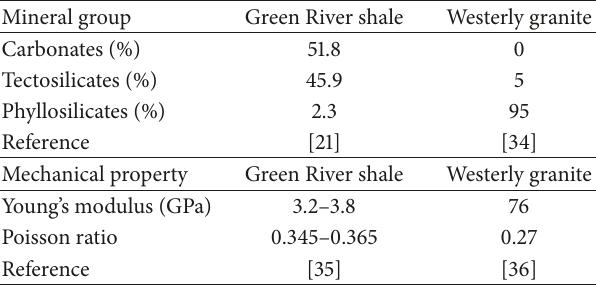
Table 1: Mineralogical and mechanical properties of GRS and